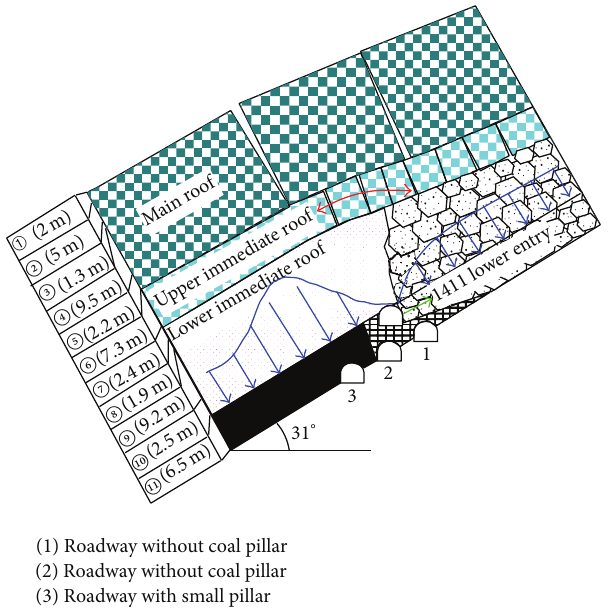
Figure 4: Structural model of lateral strata overlying the roadway driven along next goaf.